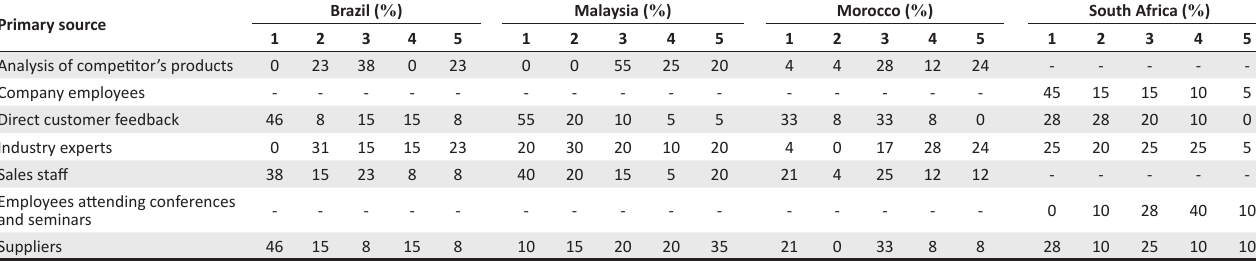
FIGURE 3: The five analytical methods or models most used by the respondents in this study.